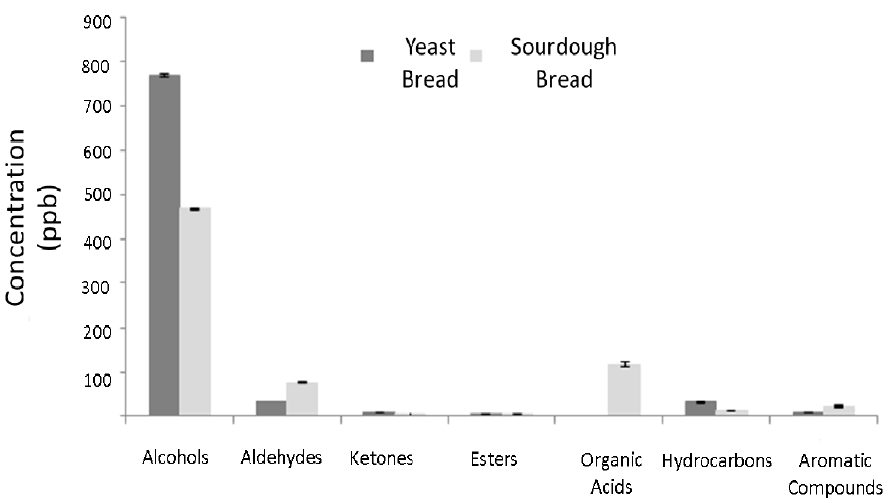
Figure 5. Bar diagram showing differences in volatile compounds between yeast bread and sour- dough bread on day of bread preparation. Alcohols identified included ethanol (alcoholic odor), 1-propanol (buttery odor), 2- methyl-1-propanol (ethereal odor), 3-methyl-1-butanol (malty odor), 2-methyl-1-butanol (fragrant odor), 1-hexanol (grass/sweet/woody odor), 1-octen-3-ol (acidic odor), and pentanol (fruity, sweet odor). The total alcohol concentration was higher ( p < 0.05) in yeast bread compared to sourdough bread (Figure 5). Ethanol is the main product of yeast fermentation. Minor products of yeast fermentation include butanol and propanol derivatives [52]. Short-chain alcohols are produced through sugar fermentation, while long- chain alcohols are produced through amino acid metabolism [53]. Of the 33 sourdough LAB isolates studied in detail by De Vuyst et al. [40], all heterofermentative LAB strains produced ethanol, lactic acid, and acetic acid in agreement with the results of the present study. L. sanfranciscensis (see below) and L. plantarum produce a wide range of volatile compounds [51]. In addition to ethanol, lactic acid, and acetic acid, heterofermentative LAB also produce ethyl acetate with some alcohols and aldehydes. Ketones and aldehydes identified in the present study include 3-hydroxy-2-butanone (buttery odor), 2,3-butanedione (intense buttery odor), 2-pentylfuranone (green/fruity odor), (hexanal (green/grass odor), 3-methyl-butanal and 2-methyl-butanal (malty odor), heptanal (green/fatty odor), benzaldehyde (bitter almond odor), octanal (fruity/soapy odor), nonanal (sweet/mellon odor), and furfural (roasted odor). Carbonyl compounds are mostly the products of hydroperoxide decomposition; i.e., hexanal and pentanal form through the decomposition of linoleic acid. The Maillard reaction also produces numerous aldehydes and ketones, i.e., 3-methyl-butanal being a product of the Maillard reaction [54] and ethanol, 2-methyl-1-propanol, 2-methyl-1-butanol, 3-methyl-1-butanol, and benzal- dehyde being products of yeast fermentation [55]. LAB also liberate aroma precursors such as amino acids, which are degraded into aldehydes or the corresponding alcohols [55]. As shown in Figure 2, aldehyde concentration was higher ( p < 0.05) in sourdough bread compared to yeast bread. The trend was reverse regarding ketones. Esters identified included methyl formate (ethereal odor), ethyl acetate (sweet odor), and methyl butyrate (apple–pineapple fruity odor). Ester production is mainly due to het- erofermentative LAB metabolism [56]. Ester concentration was higher ( p < 0.05) in yeast leavened compared to sourdough bread. Of the organic acids, acetic acid (pungent/sour odor) was identified only in sourdough bread at high concentrations. Acetic acid is the